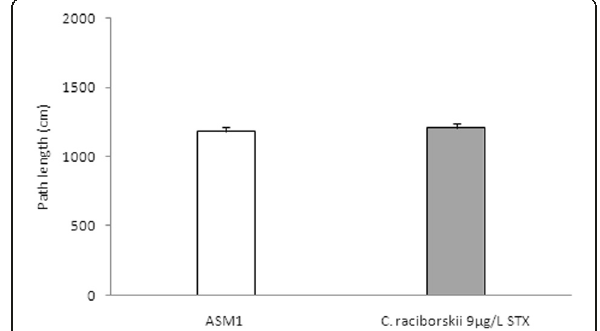
Fig. 7 Absence of effect of PST-producing C. raciborskii (9 μ g/L STX equivalents) on the swimming path length during the test session of the MWM task ( p = 0.431, one-way ANOVA test). Data expressed as mean ± SEM; n = 15 per